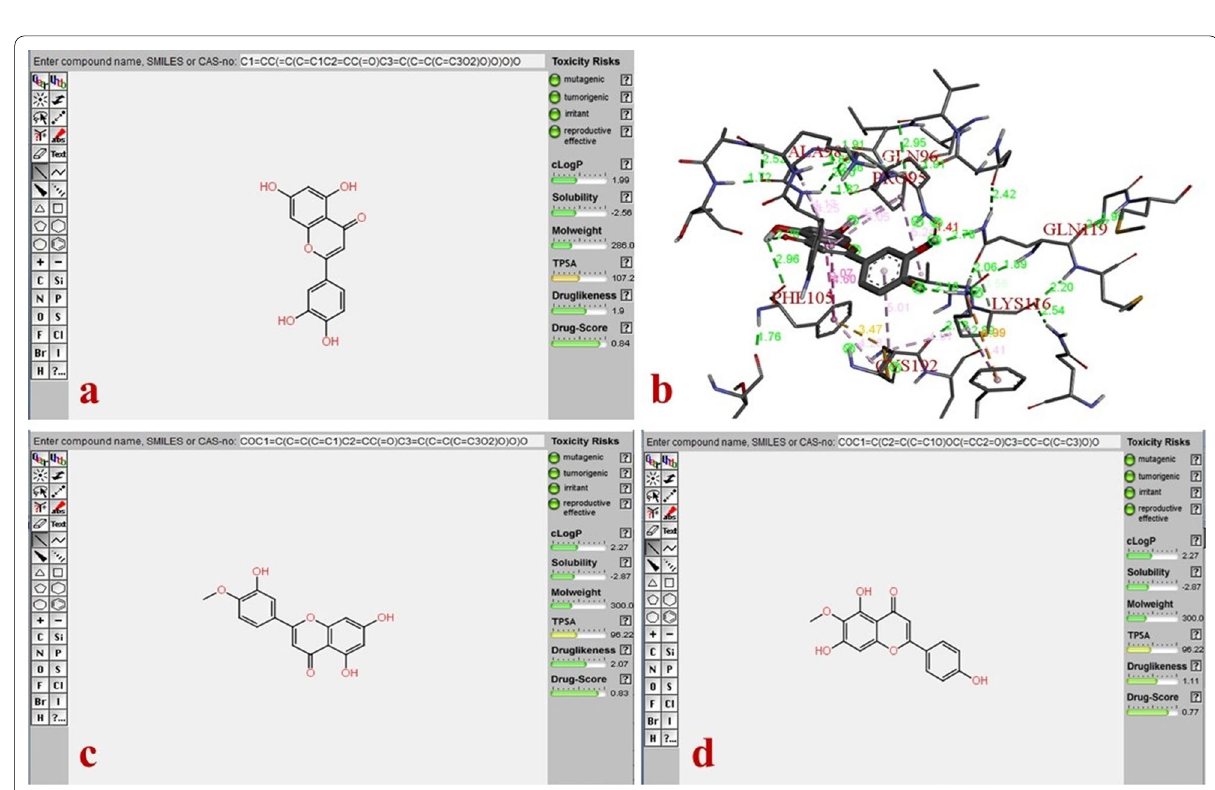
Fig. 2 Comparative study of luteolin, diosmetin and hispidulin and luteolin interaction with V2R target. a Luteolin good overall drug score (0.84) with no toxicity. c Diosmetin shows 0.83 overall drug score d Hispidulin shows 0.77 overall drug score. b shows conventional H-bonding with PHE105, GLN-119,